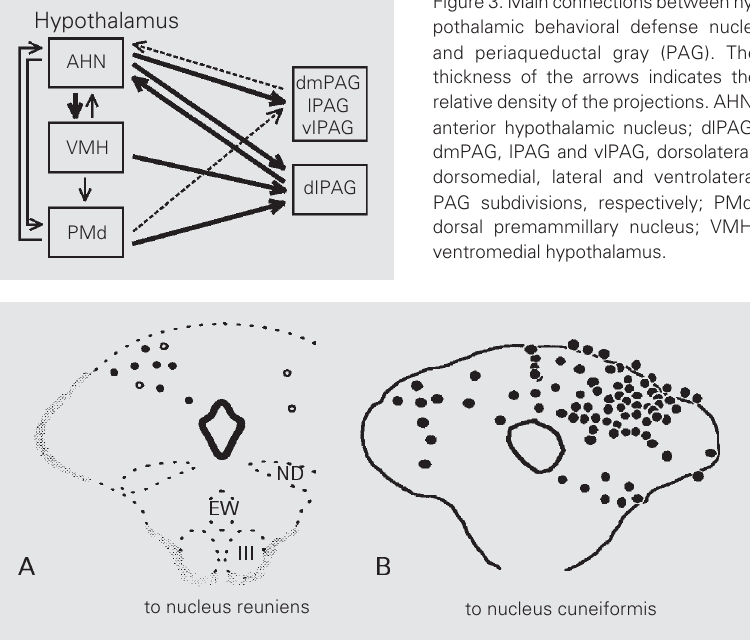
Figure 3. Main connections between hy- pothalamic behavioral defense nuclei and periaqueductal gray (PAG). The thickness of the arrows indicates the relative density of the projections. AHN,